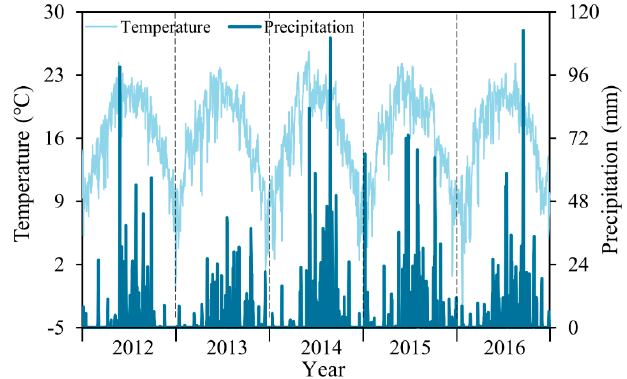
Figure 2. Air temperature and precipitation changes of Lake Dianchi for 2012–2016 .